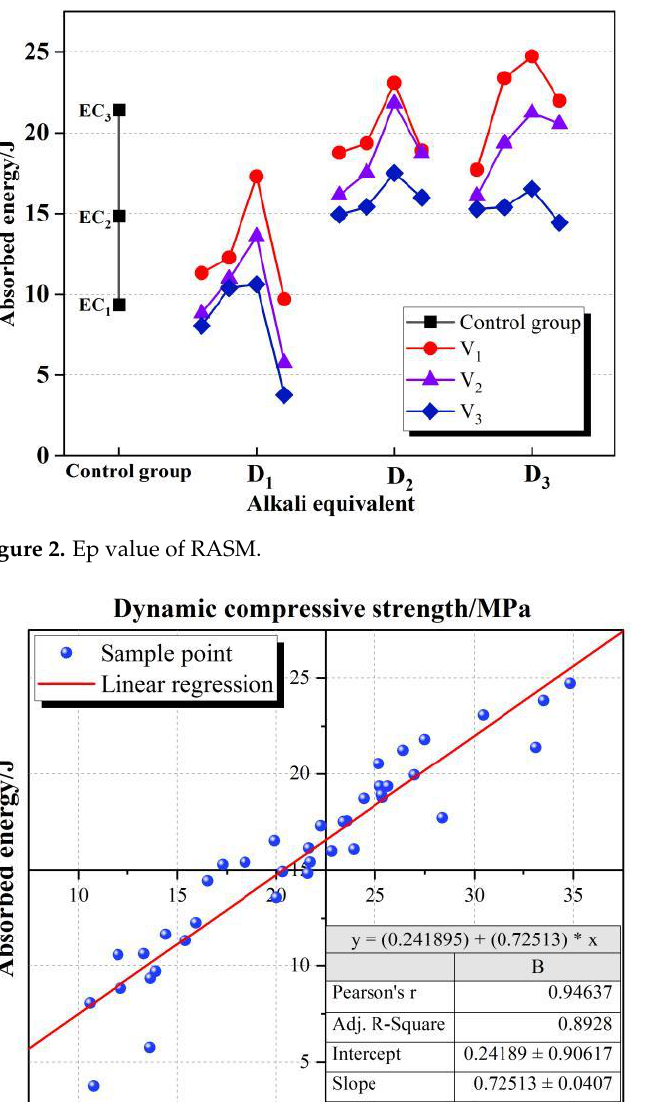
Figure 4. Correlation coefficient matrix. 3.1.2. Effect of Factor Level on Dissipated Energy According to the overall data trends, appropriately increasing the alkali equivalent of RASM specimens will improve the dynamic energy absorption capacity of RASM spec- imens. This is due to the more complete hydration reaction of alkali excitation blast fur- nace slag materials. The concrete strength of ascension increases the specimen damage total dissipation , but there is a limit to its promotion. The increase of alkali equivalent increases the amount of C-A-S-H gel produced by RASM, the ability to encapsulate slag particles increases, and the probability of OH - contacting with slag particles decreases. Therefore, the hydration degree of alkali slag cement decreases correspondingly. How- ever, at the same time, with the increase of alkali equivalent, the number of OH- ions also increases, and the vitreous structure of slag is more easily destroyed. The hydration de- gree of RASM increases first and then decreases with the increase of alkali equivalent. This rule was shown to different degrees in different V factor control groups in this experiment. When the factor level increases from V1 to V3, this trend can be intuitively reflected by the second derivative of the fitted curve, as shown in Figure 5, i.e., the fitted curves are all